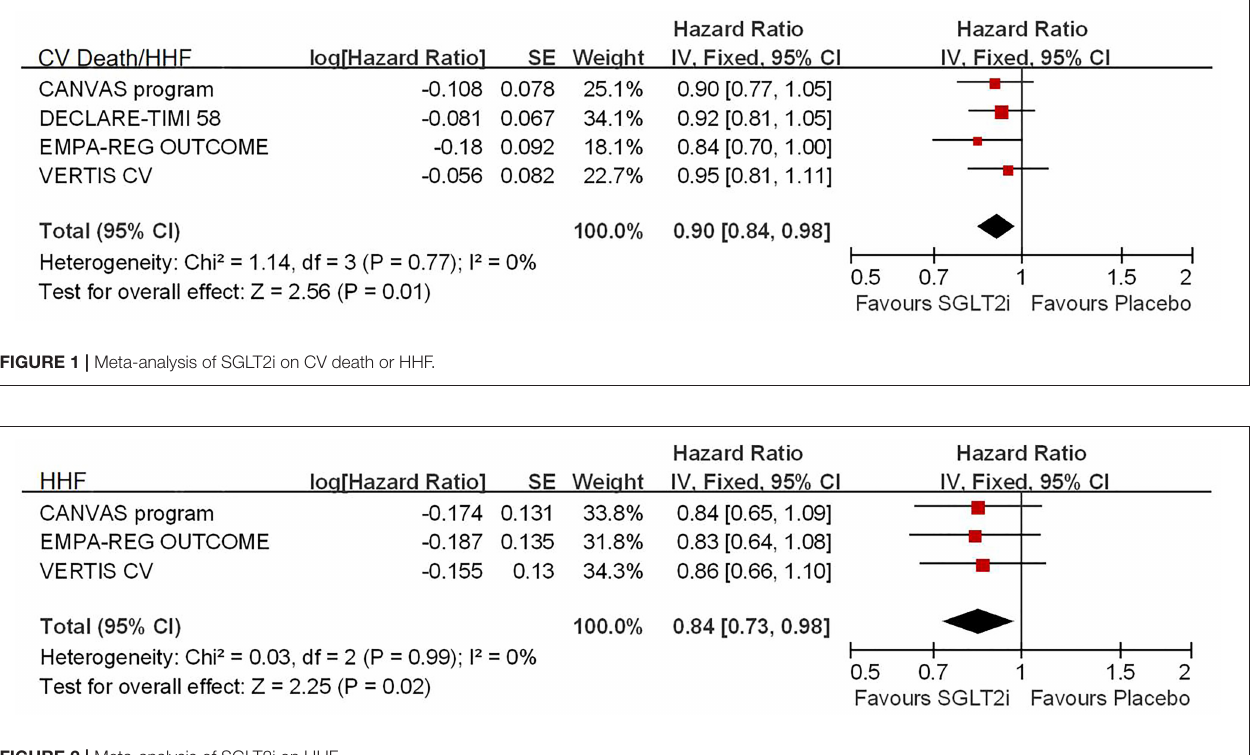
FIGURE 2 | Meta-analysis of SGLT2i on